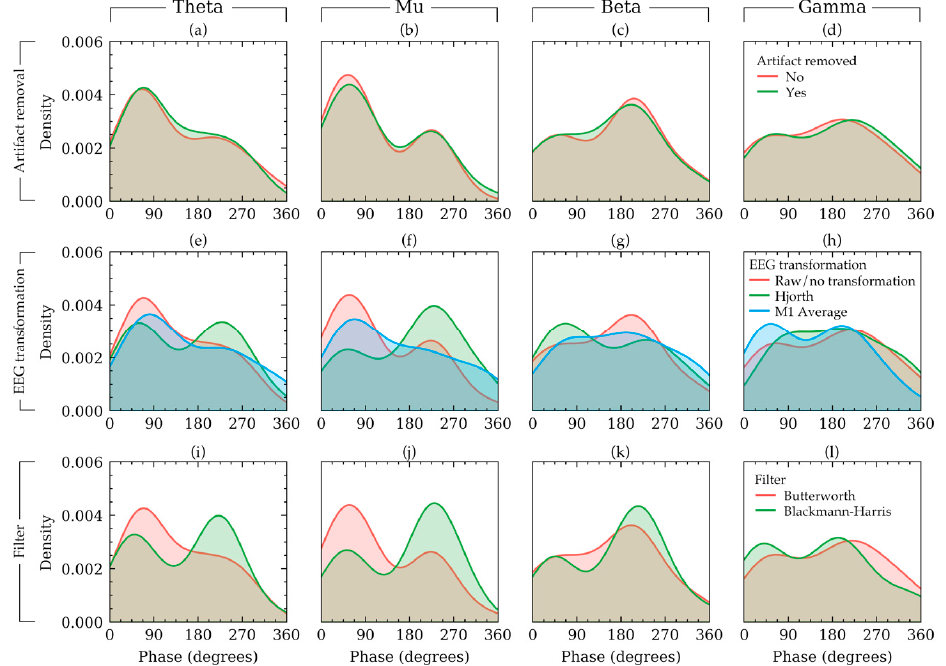
Figure 6. The density plot of phase values of a random subject in Dataset 1 illustrating how the choice of artifact removal ( a – d ), EEG transformation ( e – h ), and filter ( i – l ) affected the phase distribution for that subject. The distributions are plotted separately for four frequency bands in each column. The effect of each factor is plotted in each row keeping the other remaining factors constant with constant values. The constant values were as follows: artifact removal = yes, EEG transformation = raw, filter = Butterworth filter.